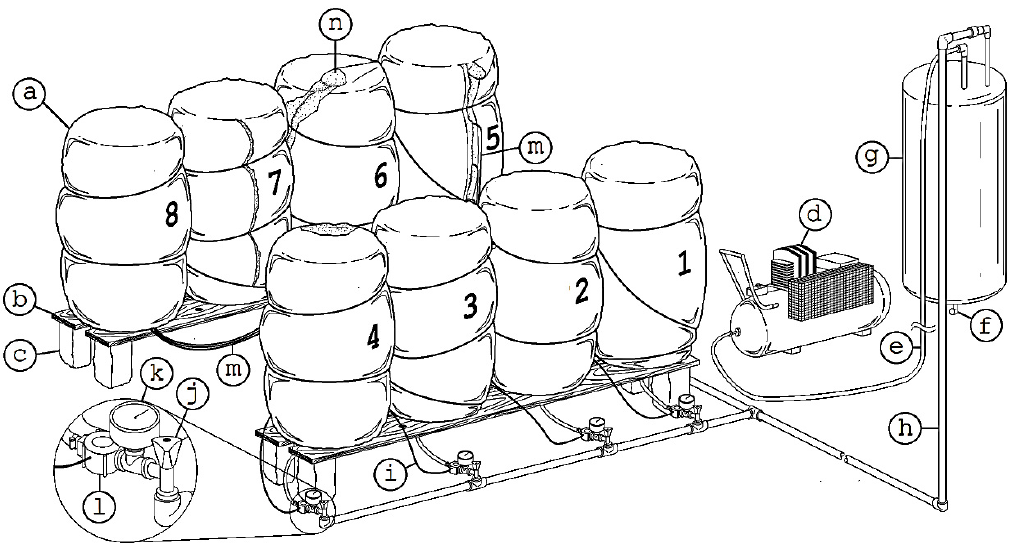
Figure 1. Experimental setup of composting DSR. (a) barrels covered with insulation material and aluminum foil; (b) wooden beam; (c) base from bricks, (d) air compressor, (e) hose for forcing air into the heater, (f) water inlet, (g) water heating vessel, (h) air and water vapor mixture outlet, (i) water flow sensor cable, (j) valve, (k) manometer, (l) water flow sensor, (m) temperature sensors cables, and (n) insulating